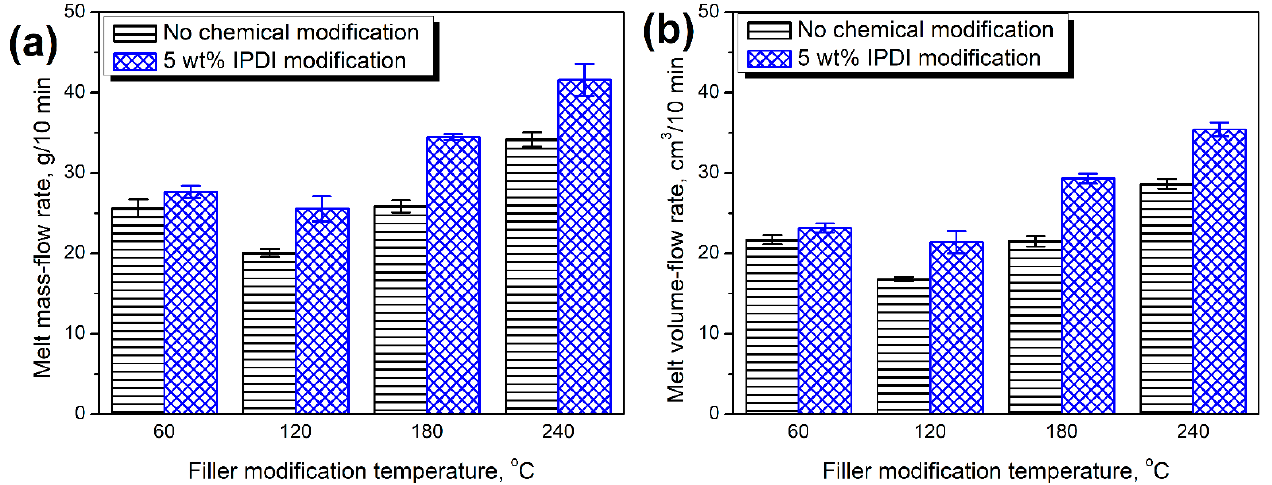
Figure 6. Values of ( a ) melt mass-flow rate and ( b ) melt volume-flow rate measured for different composite